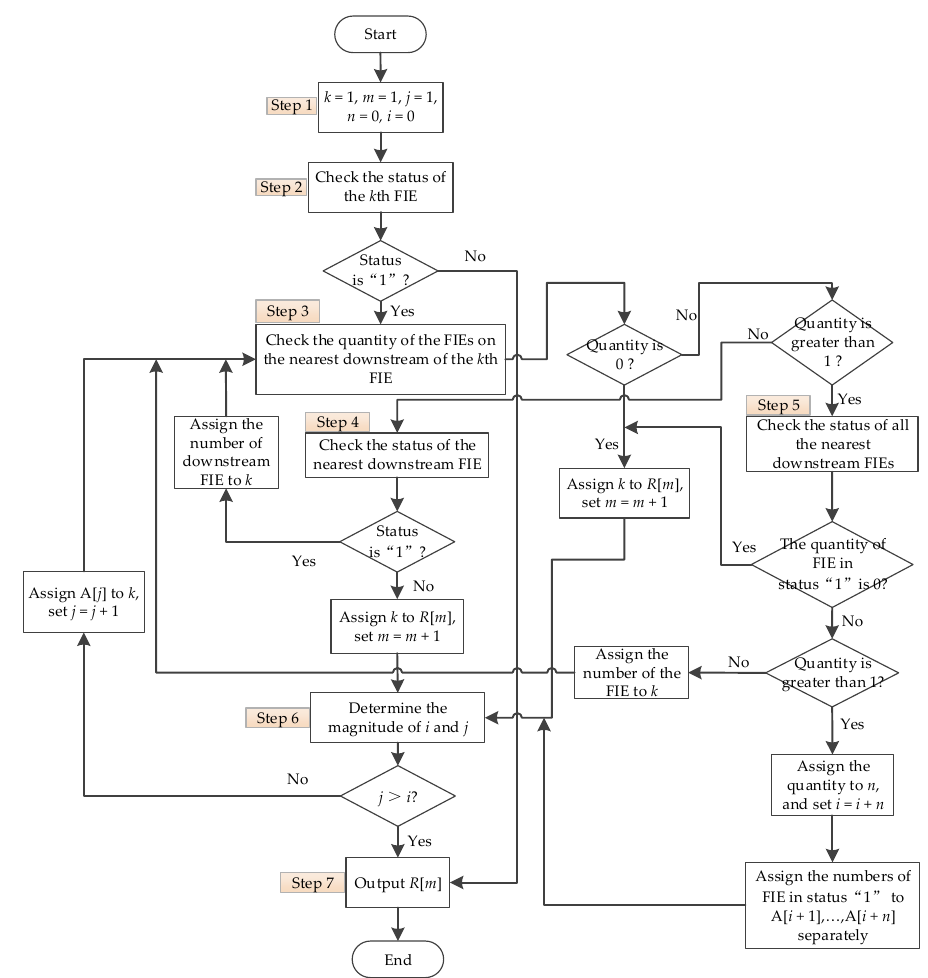
Figure 3. Flow chart of the topology search algorithm.